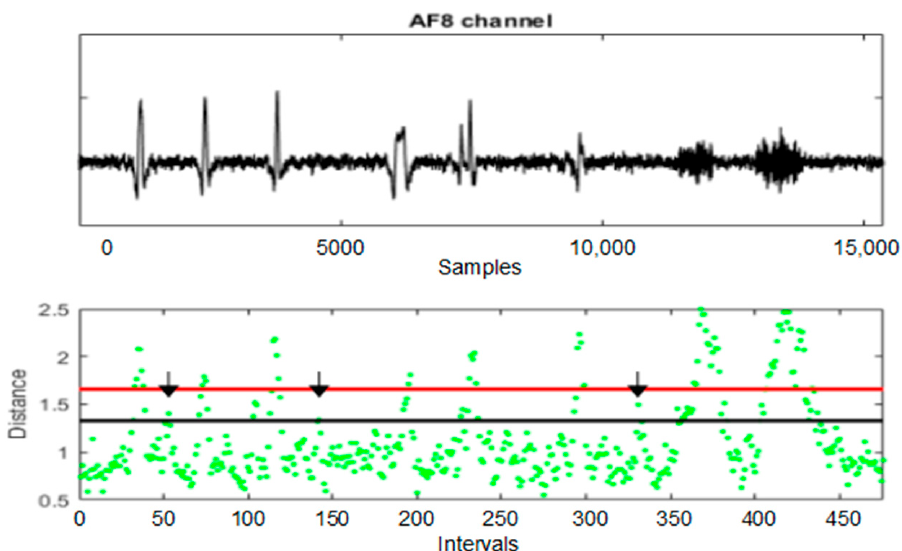
Figure 16. A SEEG channel, the distances of the intervals to their centroid and the thresholds T 1 (in black) and T 2 (in red). The black arrows point at some intervals not related to the simulated artefacts.